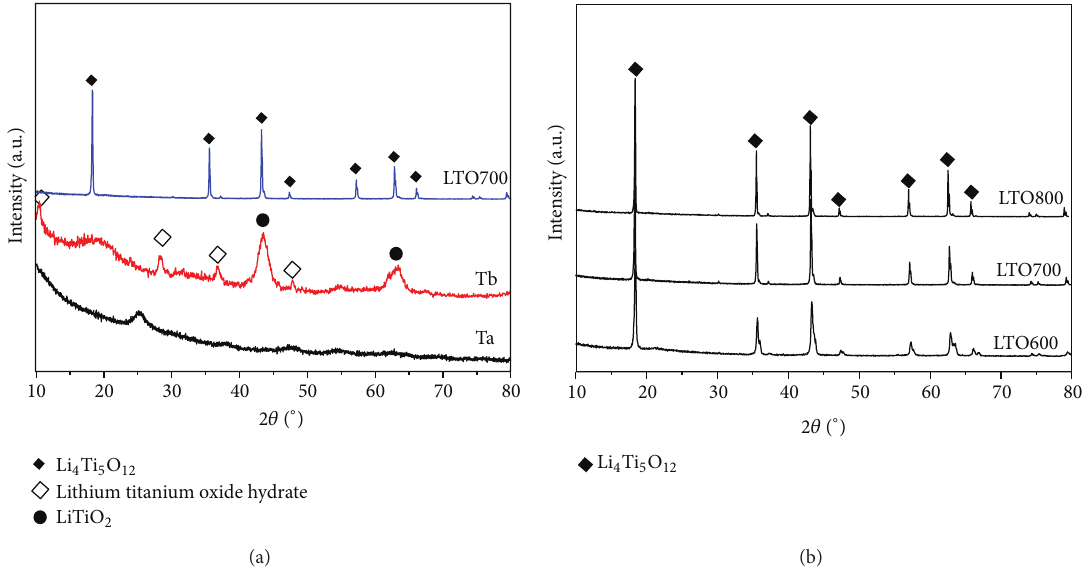
Figure 1: The XRD patterns of samples Ta, Tb, LTO700 (a), and LTO sintering at different temperatures (b).